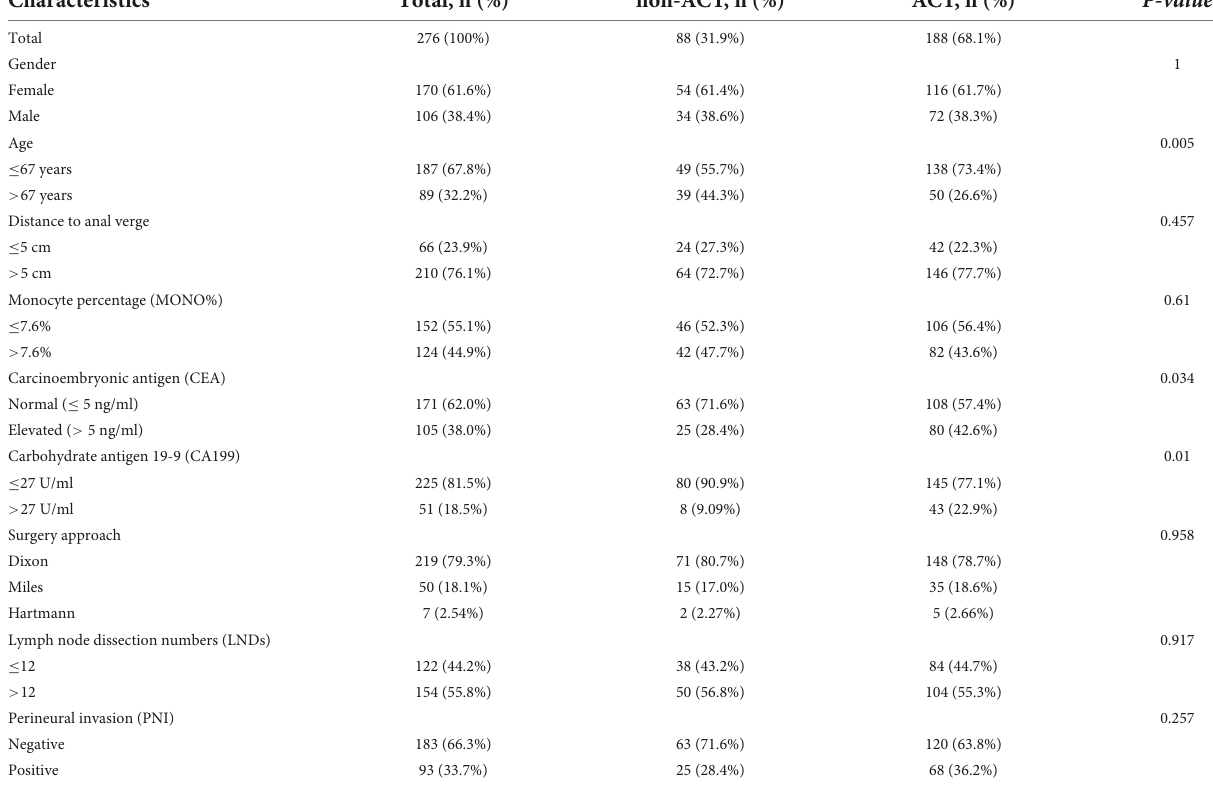
TABLE 1 Baseline clinicopathologic characteristics of the patients with pT3N0M0 rectal cancer. Characteristics